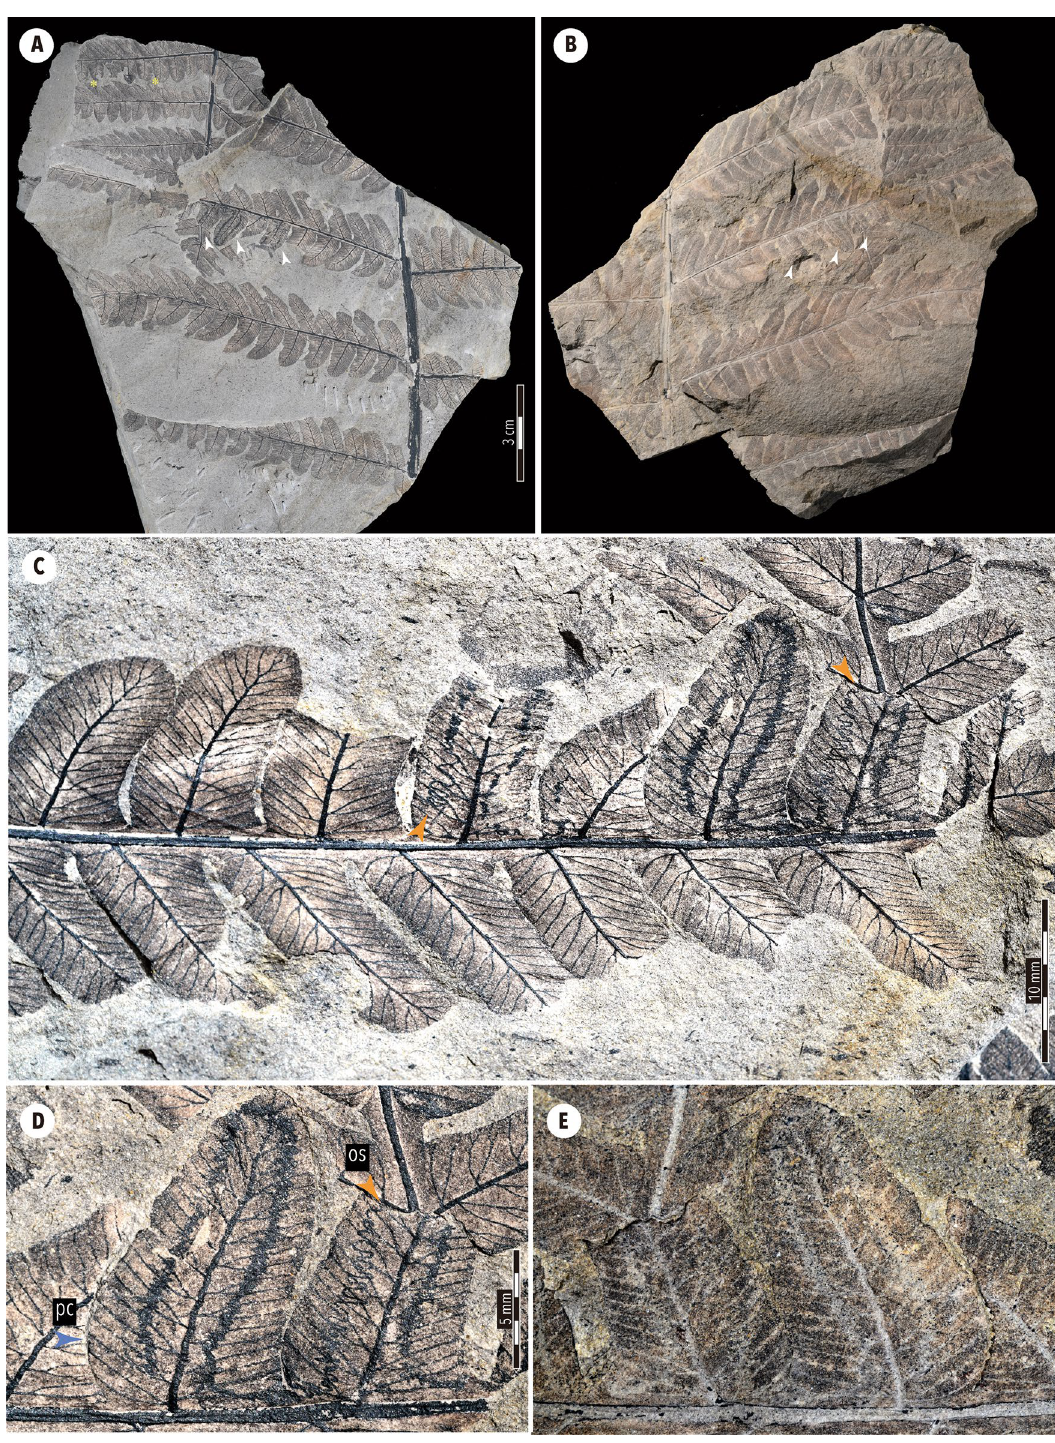
Figure 2. Late Triassic leaf-mine fossil on Cladophlebis denticulata of the Momonoki Formation, Yamaguchi, Japan. ( A ) Specimen (MMHF11-00001a), on which mines on pinnules and chewing marks are marked with white arrowheads and yellow asterisks, respectively, and ( B ) its counterpart (MMHF11-00001b), at approximately the same scale. ( C ) Enlargement of pinna with three mines; orange arrowheads signify putative starting point (i.e., oviposition site) of leaf-mines; however, the starting point of the mine on the right is unseen. ( D ) Enlargement of two pinnules shows the transition of the frass trail, suggesting larval development while mining, and ( E ) its counterpart at the same scale. Arrowheads in orange and blue denote an oviposition site (os) and possible pupal chamber (pc),